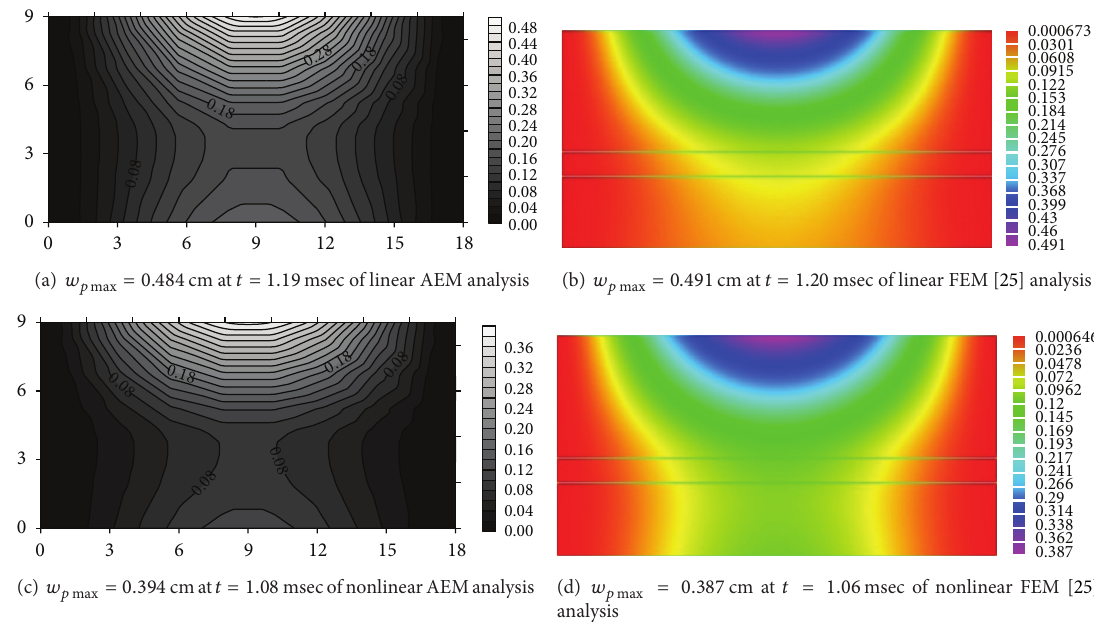
Figure 6: Contour lines of 𝑤 𝑝 of the stiffened plate of Example 1, employing the present study (a, c) and a FEM [25] solution using solid elements (b, d) at the time of maximum transverse displacement.